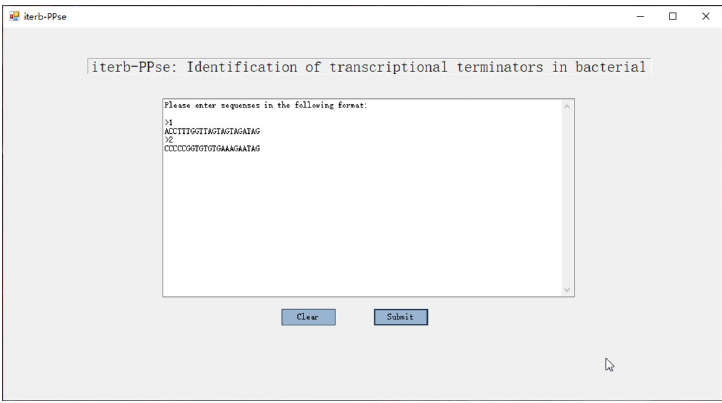
Fig 11. Main form of prediction tool. Just enter the sequence into the text box to get the prediction